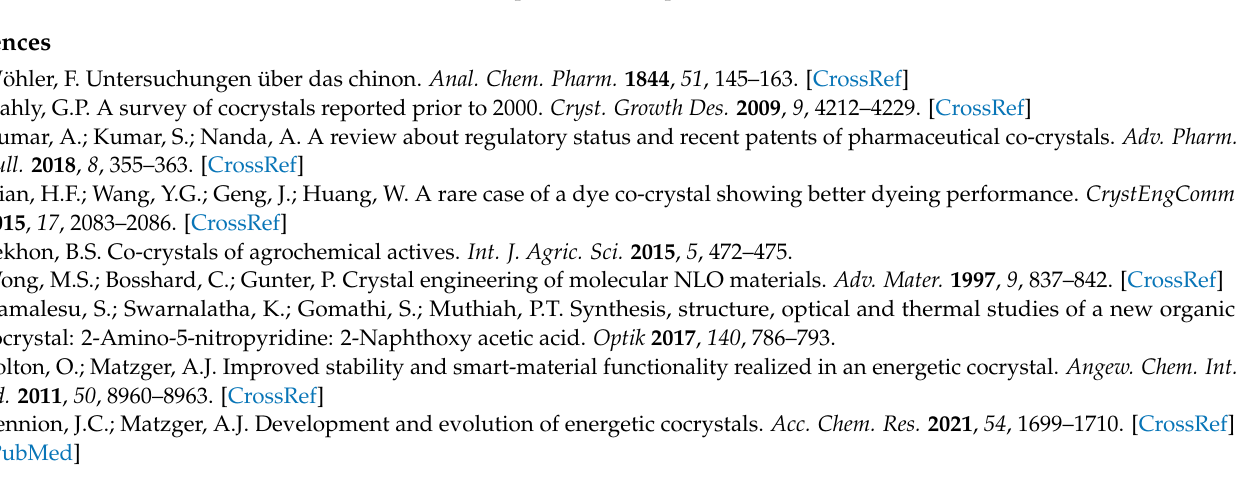
MA:Phe structures at 293 K and 25 K; Figure S3. Enthalpy of solution of maleic acid in water as a function of the H 2 O/MA molar ratio, CIF files with the single-crystal X-ray diffraction structures